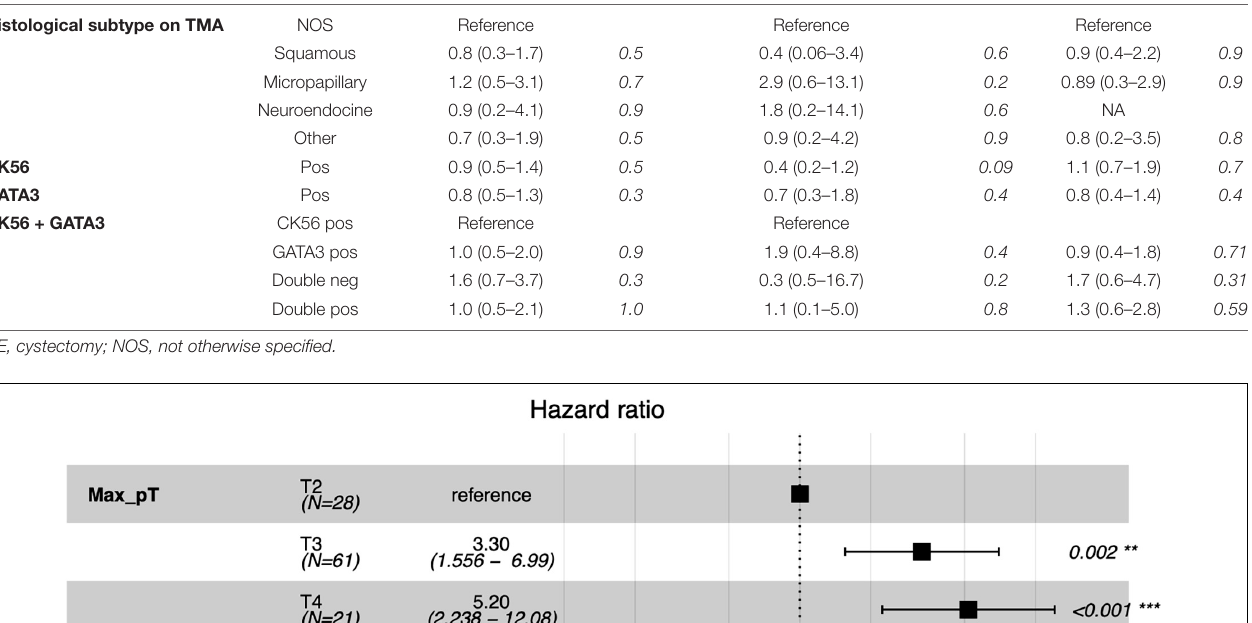
TABLE 4 | Univariate cox-regression model for histological subtype and IHC-markers CK5/6 and GATA3 stratified for patients with and without adjuvant chemotherapy. Total cohort ( n = 110) p Adjuvant chemotherapy ( n = 35) p CE only ( n = 75)